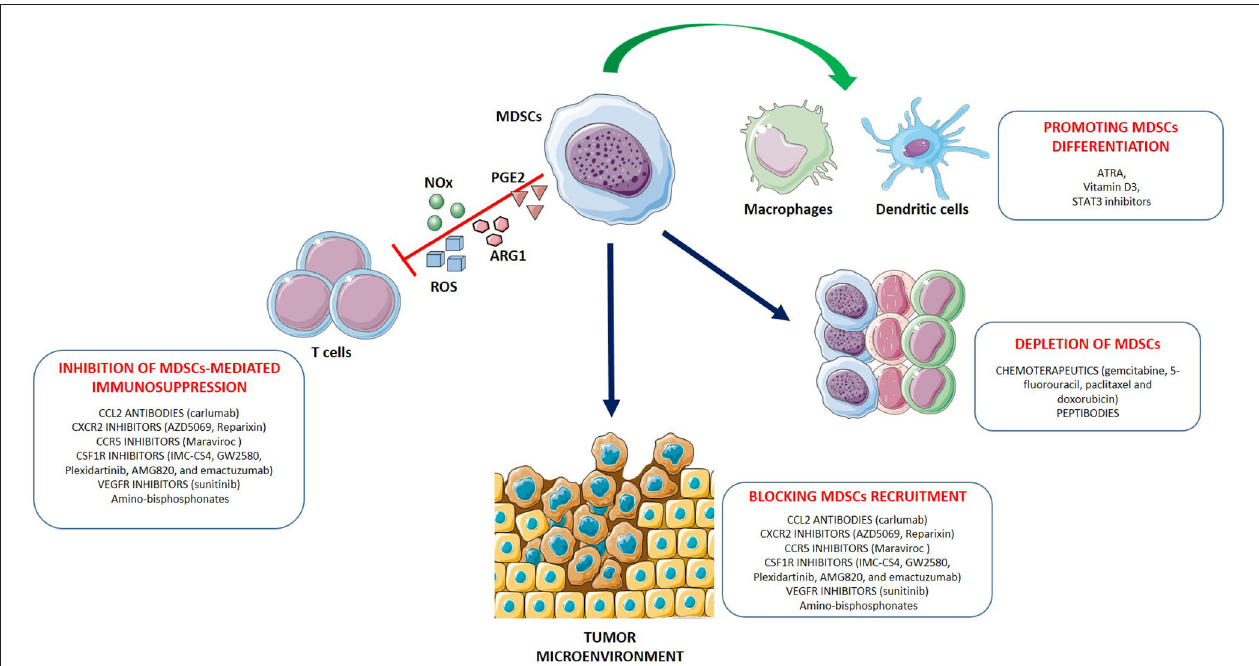
FIGURE 1 | Strategies for myeloid-derived suppressor cells (MDSC) targeting. The main approaches to target MDSCs include: (1) depleting MDSC populations; (2) preventing MDSC recruitment and migration to the TME; (3) attenuating the immunosuppressive mechanisms of MDSCs by downregulating the expression of ARG1, iNOS, COX-2 and reducing ROS generation; (4) promoting the differentiation of MDSCs into mature non-suppressive myeloid cells like macrophages and dendritic cells. Examples for each therapeutic approach are